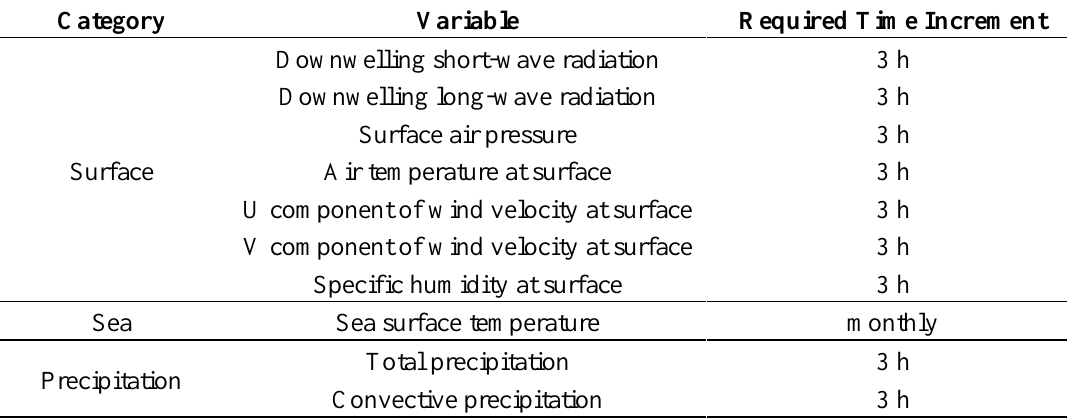
Table 2. List of required meteorological input data to drive the UrbClim